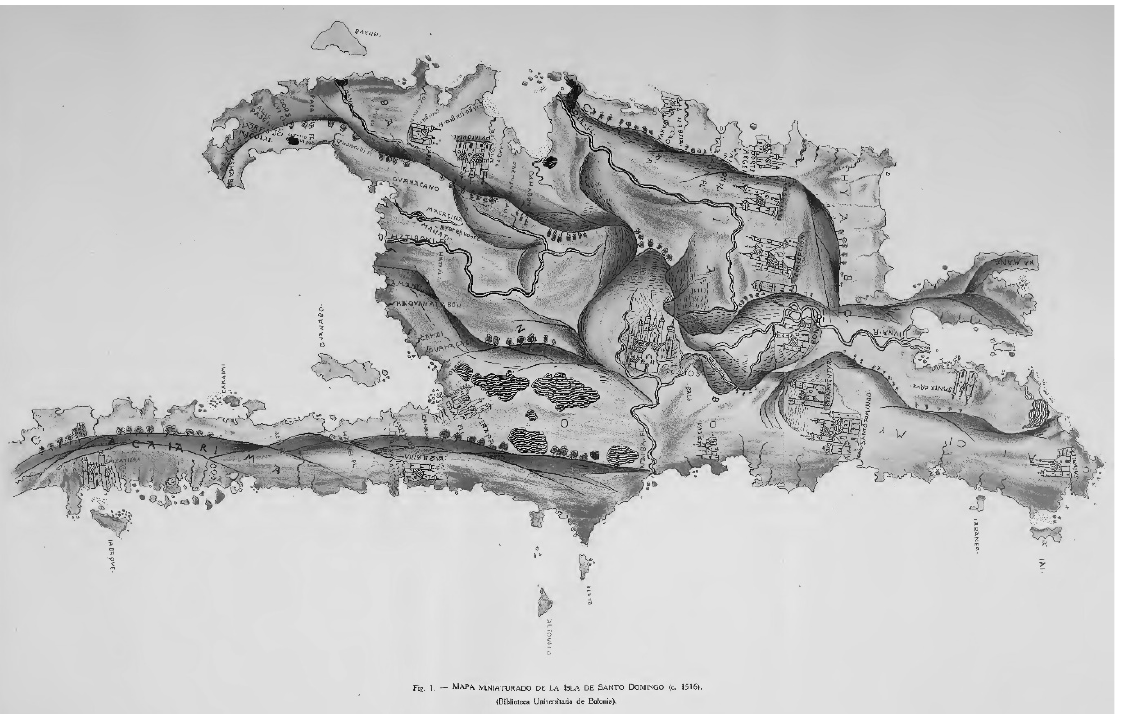
Figure 8. Map of Haytí during the early colonial period by Andres de Morales in 1516 (taken from Frati [55]).